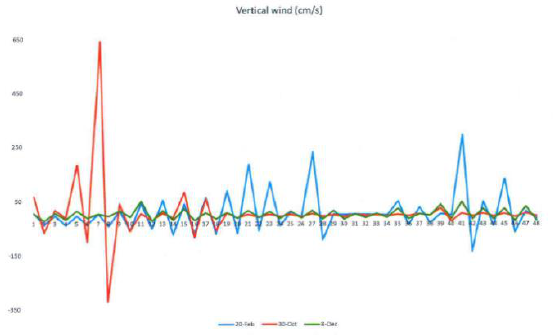
Figure 17. Maximum and minimum vertical wind speeds (cm s − 1 ) measured during each of the three WRF simulations. Blue line = February (AR) case; red line = October case; green line = December case.